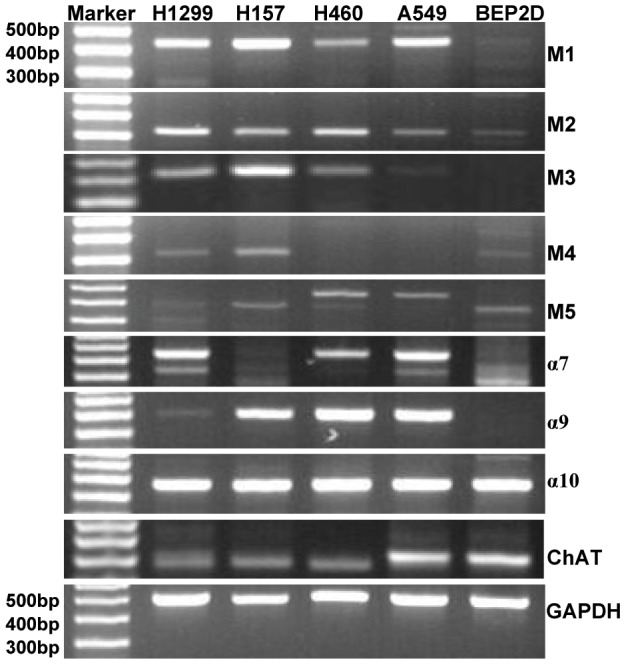
mRNA expressions of cholinergic receptors and choline acetyltransferase in NSCLC cell lines.RT-PCR was performed on total RNA prepared from the indicated cell lines. Primers were described in Table 3. GAPDH was used as loading control.